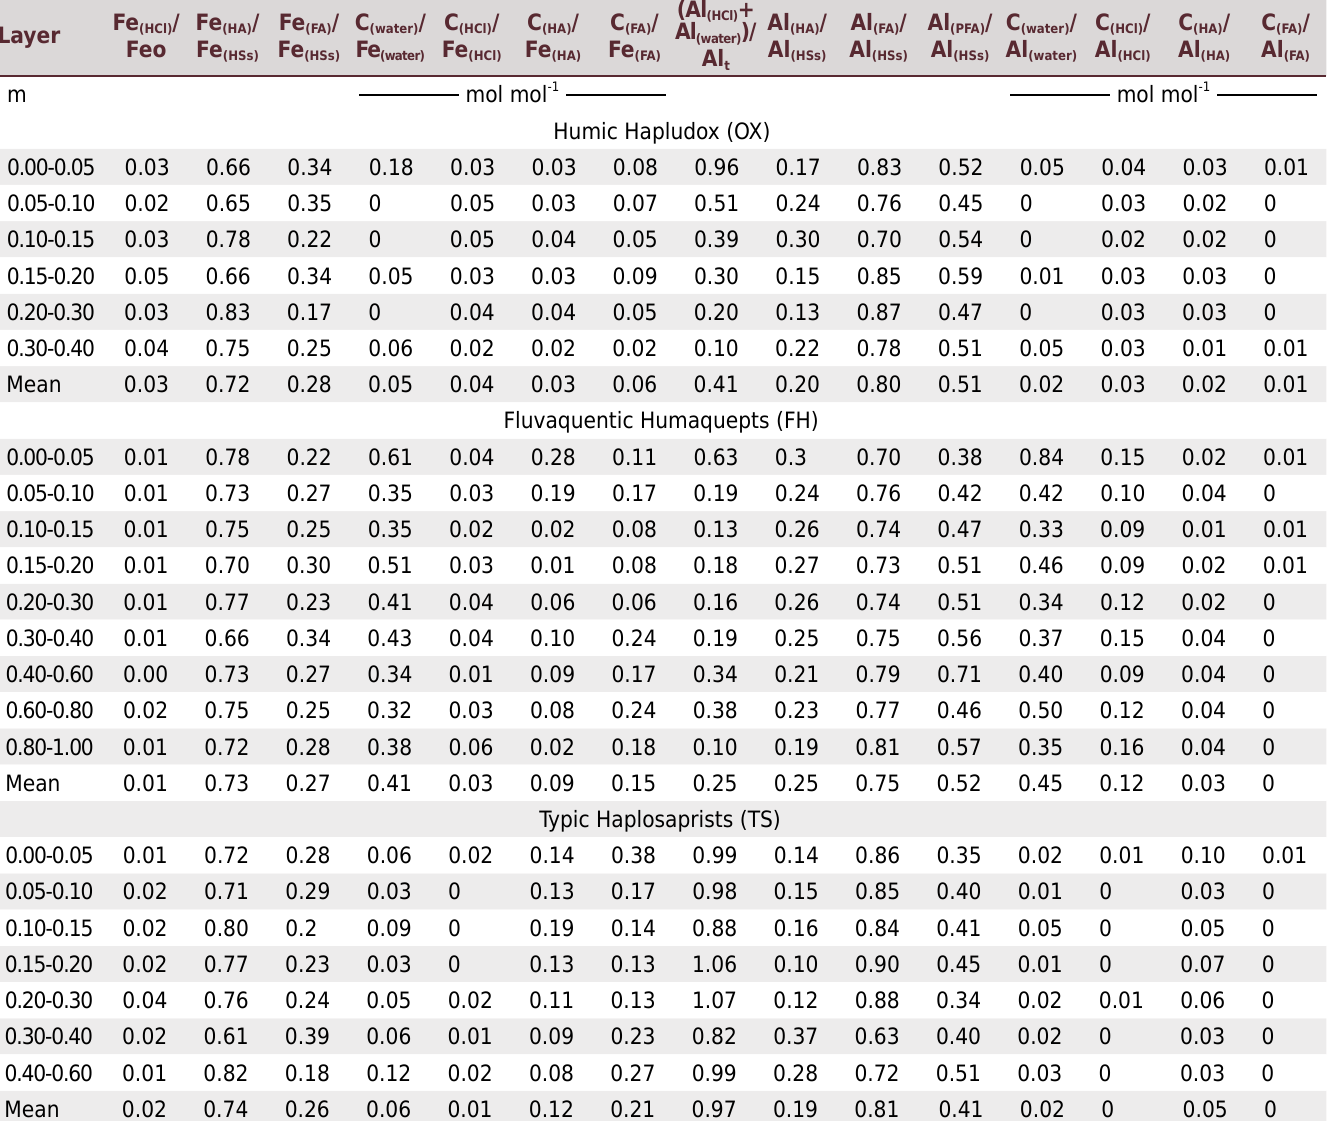
Table 6. Relation between Fe, Al, and C contents, determined in different chemical and mineralogical compartments of soils in a toposequence under Araucaria moist forest in southern Brazil Fe (HA) / Fe (HCl) / Layer Feo m